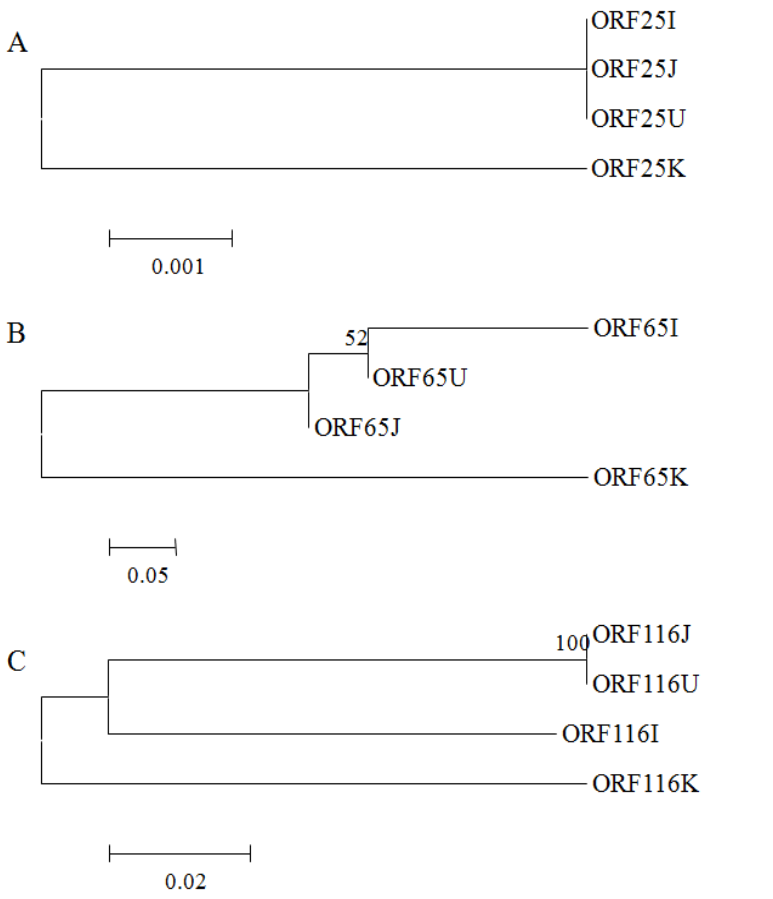
Figure 4. Phylogenetic trees were conducted on the sequences of the glycoprotein gene (open reading frame [ORF]25, ORF65 and ORF116) from Korea (KHV-K), the USA (KHV-U), Israel (KHV-I), and Japan (KHV-J)